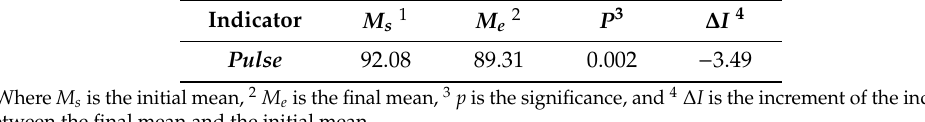
Table 4. t -test: paired two sample for means Figure 10. Thermal variation in the six thermal biomarkers.